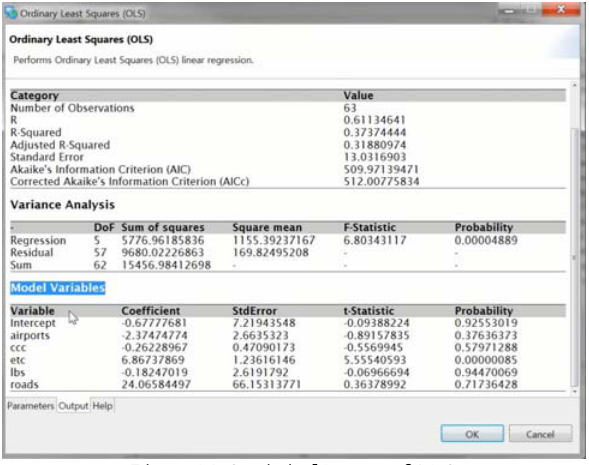
Figure 14. Statistical Report of